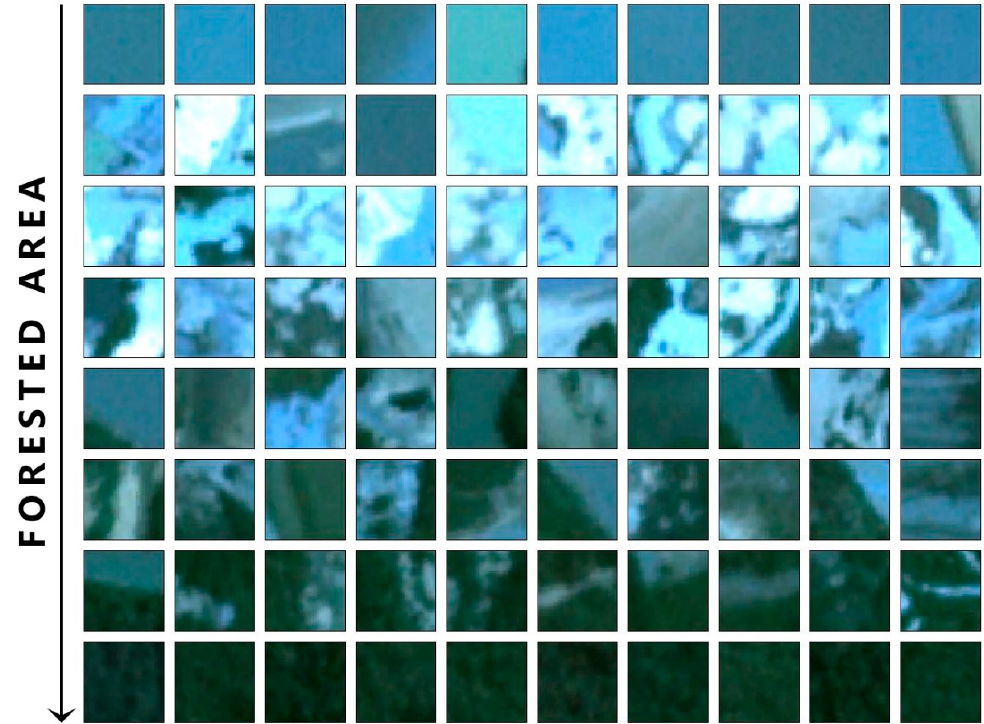
Figure 4. Sampled image patches from K-means clustering of the spectral projection. This clustering generated an unsupervised rough terrain classification that appears to group forested, mixture, and various unforested states into categories with a range of different average TCH values. These clusters were used as a proxy for the implicit categorical variable that partially drives the continuous TCH variable and were used to inform an inverse-frequency weighting scheme used during model fitting.